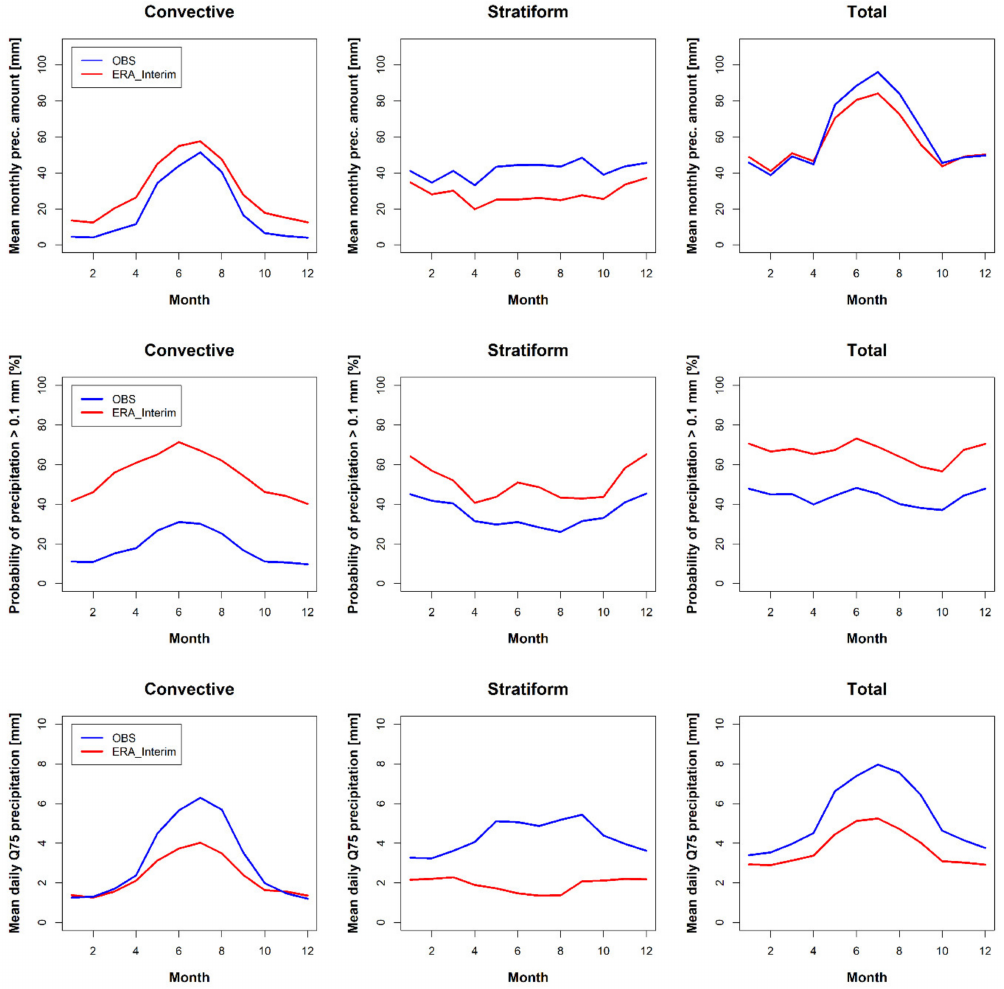
Figure 2. Mean annual cycle of monthly precipitation amounts ( top ), precipitation probability ( middle ), and 75th percentile of daily precipitation amounts ( bottom ) in observations (OBS) and ERA-Interim. Precipitation characteristics are averaged for stations (blue) and grid boxes (red) over the area of the Czech